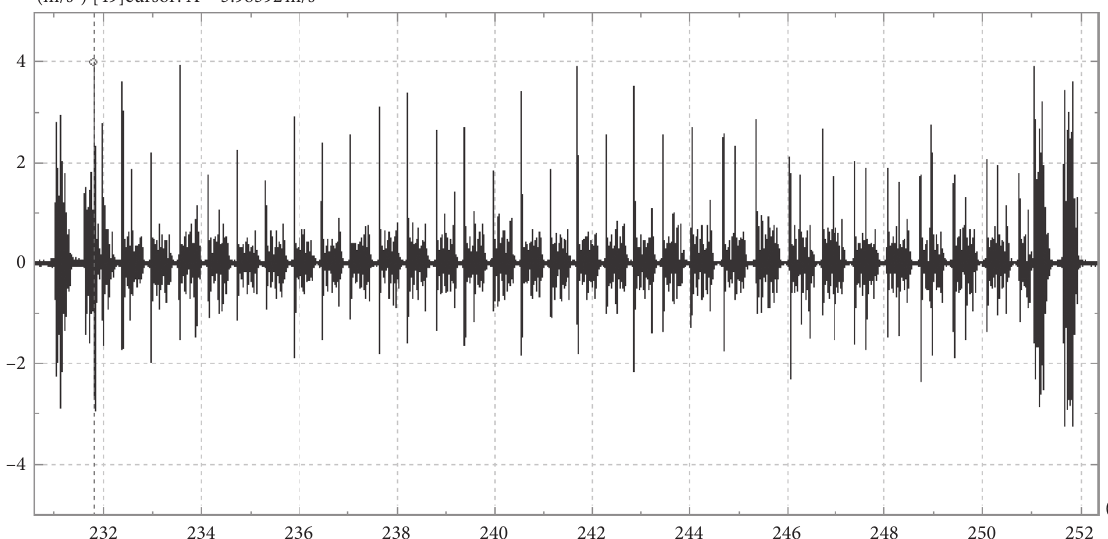
Figure 18: Time domain characteristic diagram of vibration acceleration along the line perpendicular direction ( X -axis) in the fracture